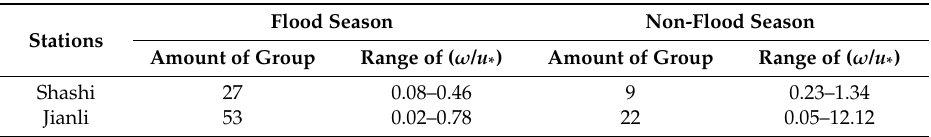
Table 5. Characteristics of vertical profiles measured at Shashi and Jianli hydrological stations before TGD dam